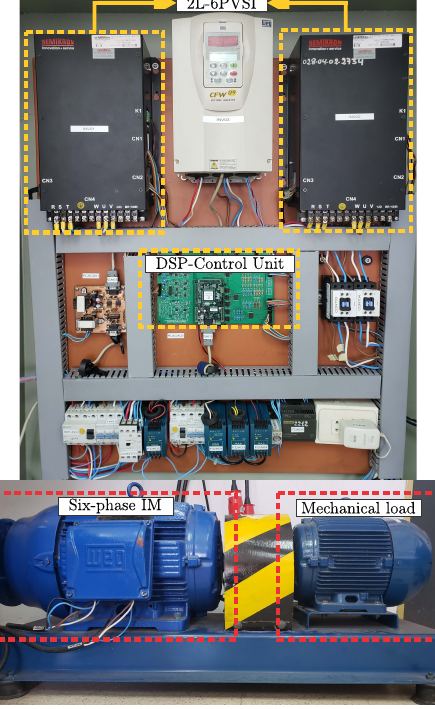
Figure 7. Test bench composed of the 2L-6PVSI, DSP unit control, six-phase IM and the mechani- cal